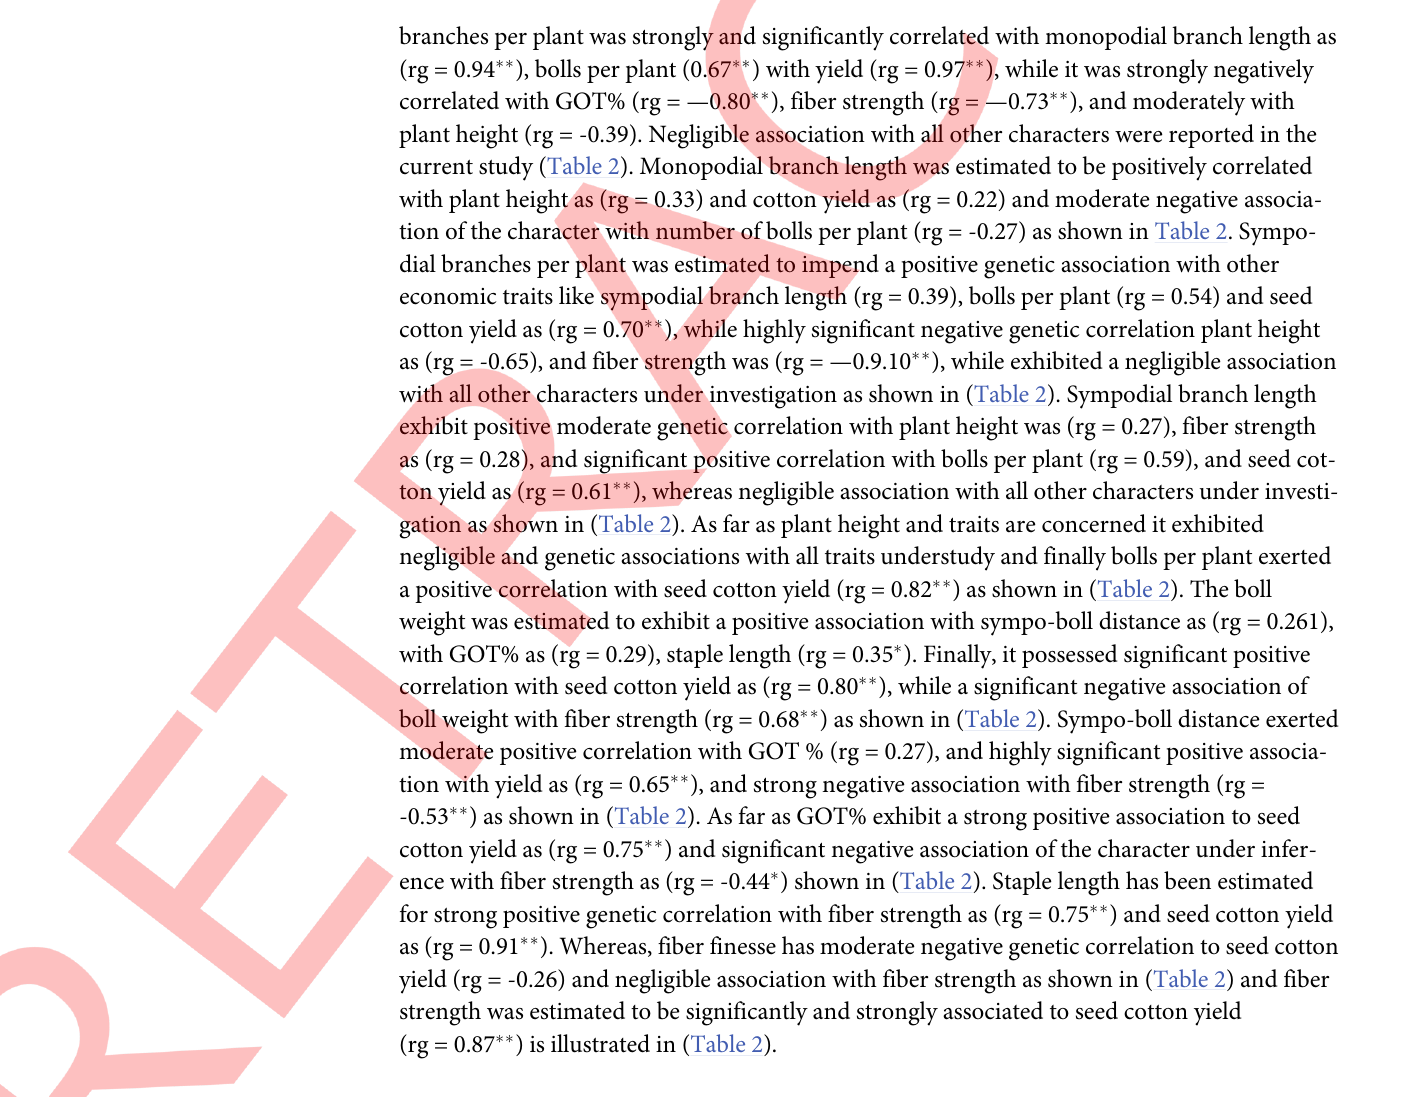
branches per plant was strongly and significantly correlated with monopodial branch length as (rg = 0.94 �� ), bolls per plant (0.67 �� ) with yield (rg = 0.97 �� ), while it was strongly negatively